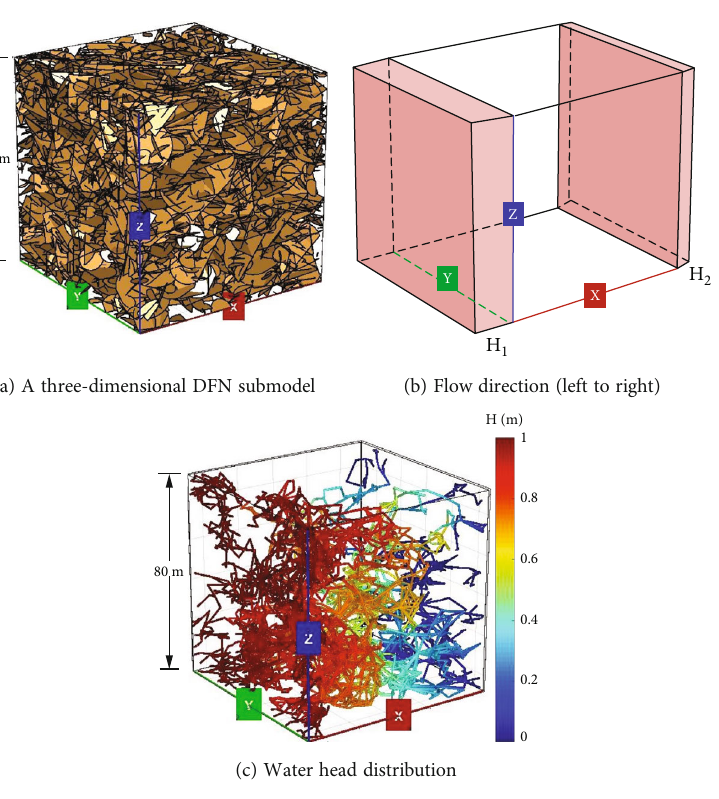
Figure 10: Hydraulic boundary conditions of cube submodels and corresponding distributions of water